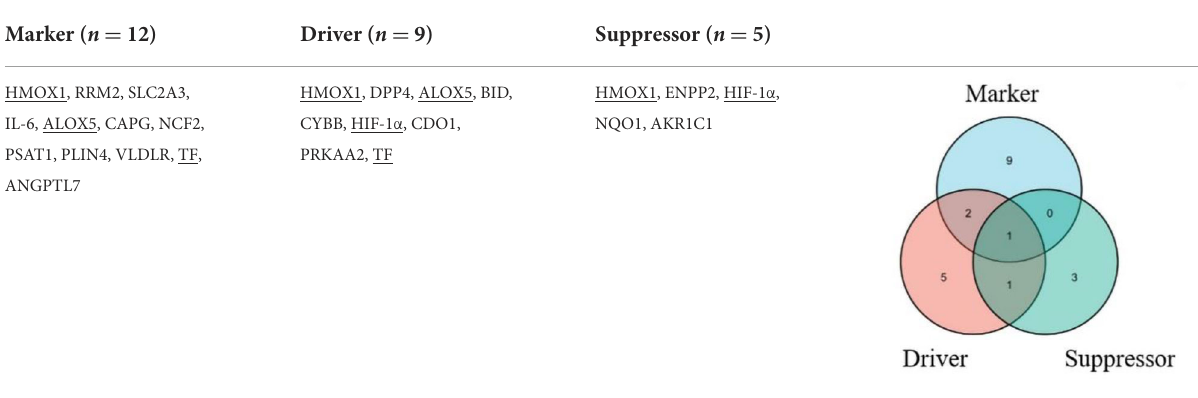
TABLE 2 Classification of the ferroptosis